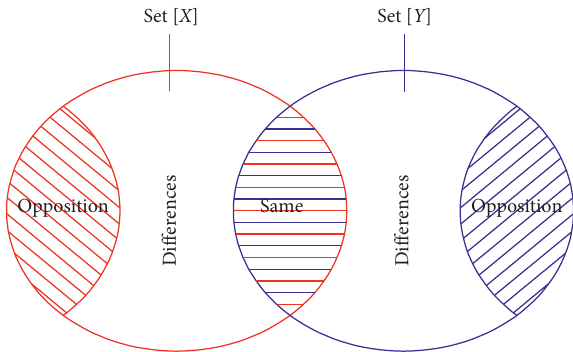
Figure 1: Same, difference, and opposition relationships of a set pair.